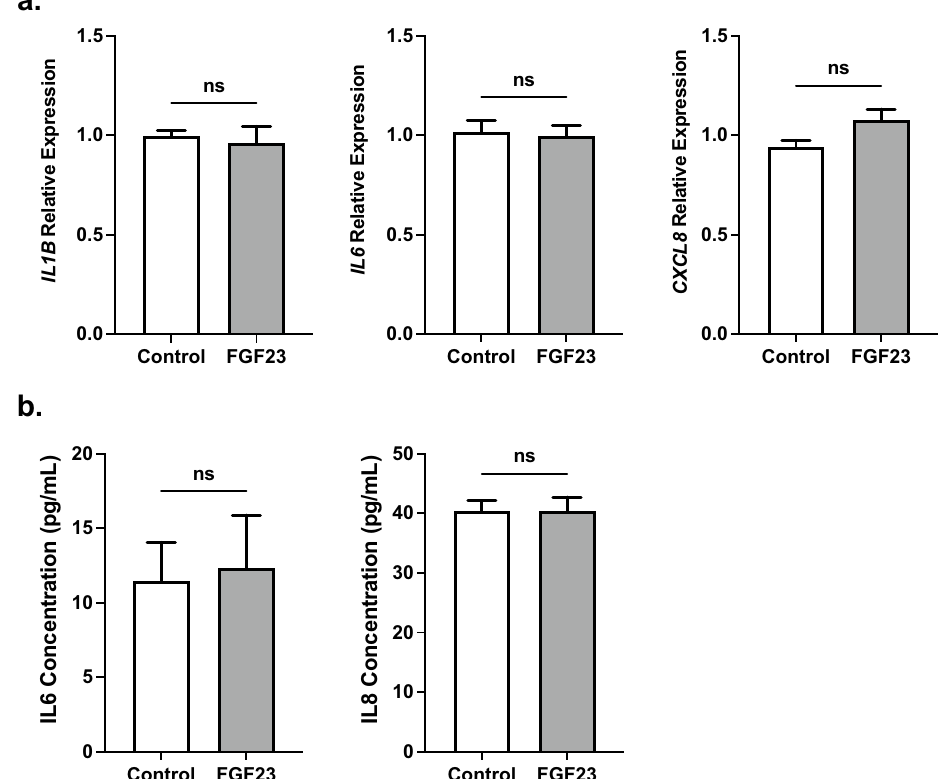
Figure 3. FGF23 does not induce inflammatory cytokine upregulation or secretion in HBECs. ( a ) Relative mRNA transcript levels of IL1B , IL6 , and IL8 in BEAS-2B HBECs after 24 h FGF23 stimulation. ( b ) IL6 and IL8 protein levels in conditioned media. All experiments were reproduced 3 times with triplicates. All values are mean ± SEM with *p ≤ 0.05, **p < 0.01, and ***p < 0.001. Statistical significance was analyzed via unpaired Student’s t -test ( a , b